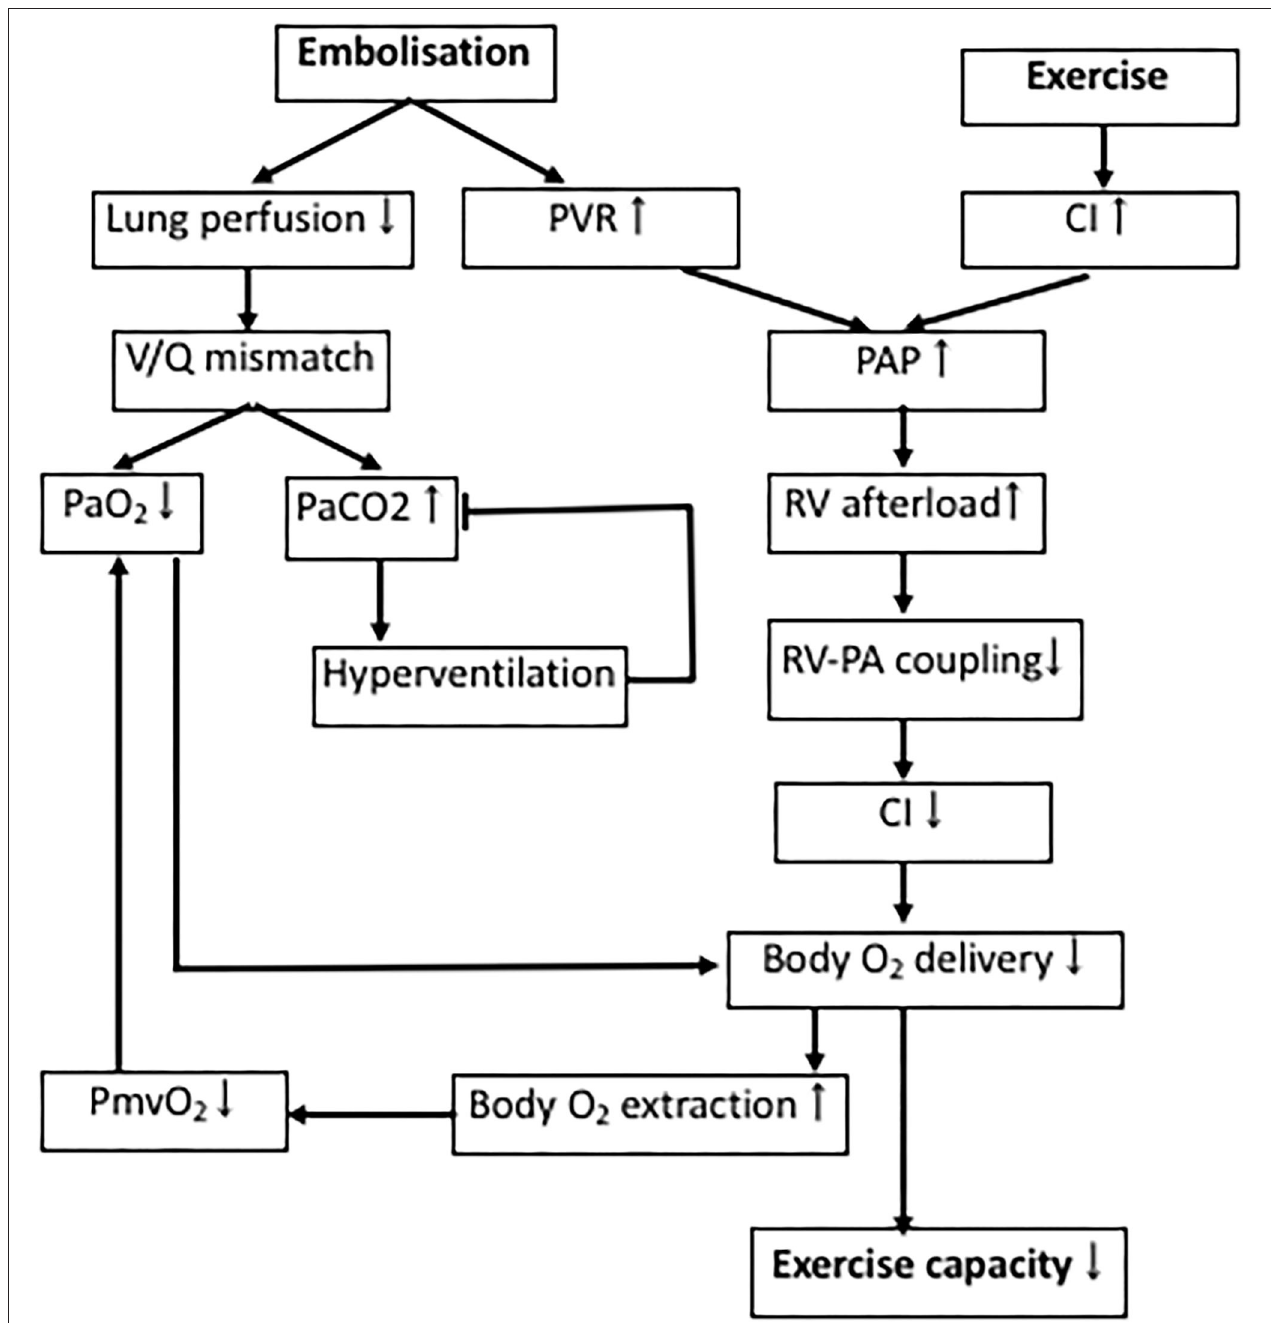
FIGURE 3 | Determinants of exercise intolerance in CTEPH. Processes involved in decreased exercise tolerance in CTEPH. PAP, pulmonary artery pressure; PVR, pulmonary vascular resistance; RV, right ventricle; V/Q-mismatch, ventilation/perfusion-mismatch; P mv O 2 , mixed venous oxygen pressure; P a O 2 , arterial oxygen pressure; P a CO 2 , arterial carbon dioxide